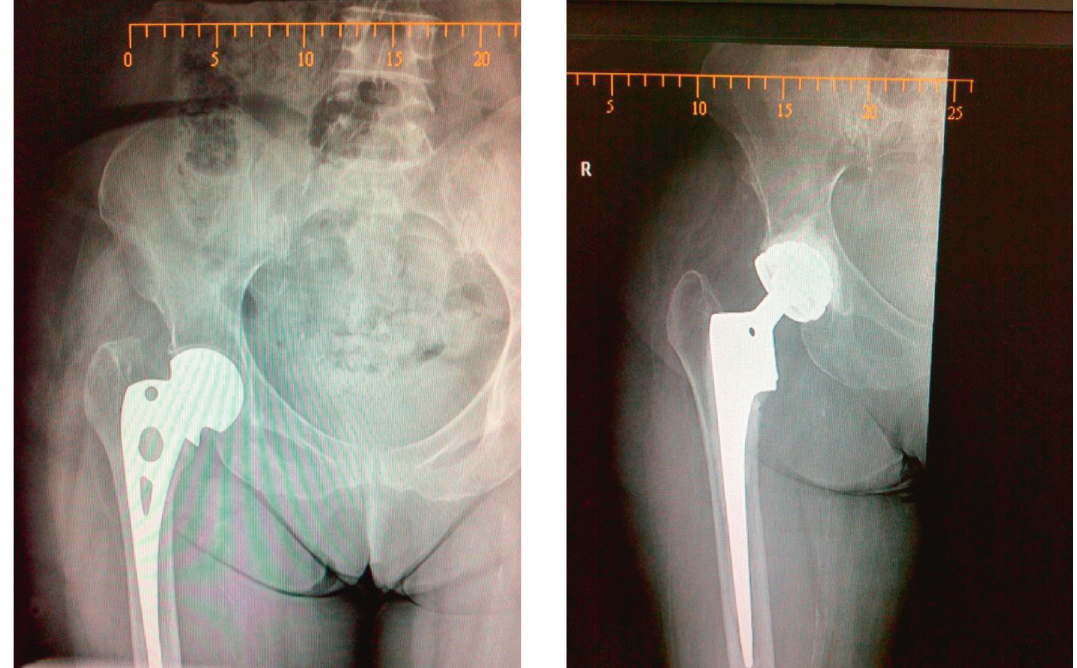
Figure 2. Failed Austin Moore prosthesis managed with calcar bearing dual mobility THR.